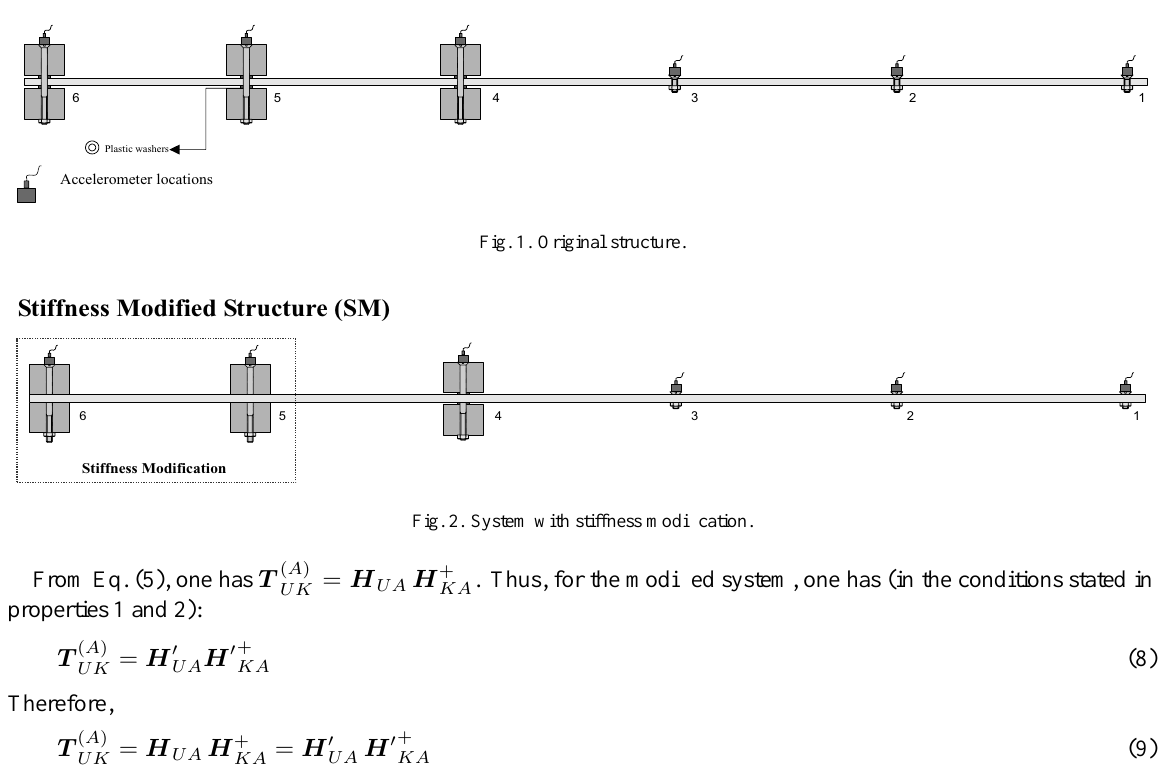
Fig. 2. System with stiffness